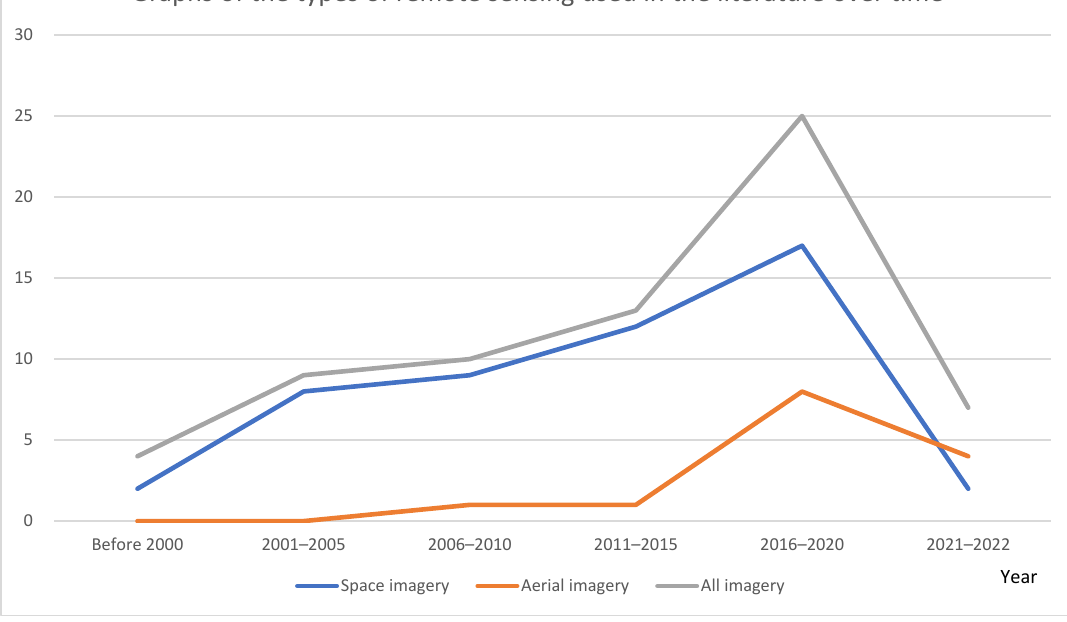
Figure 6. Graphs of the types of remote sensing used in the literature over time.